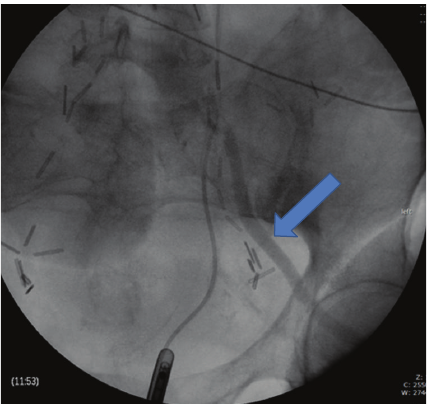
Figure 2: Attempted left internal iliac artery selective arteriogram with a 5 F SOS catheter shows the catheter tip in the left ureter and brisk flow of contrast into the left ureter (solid blue arrow) flowing caudad into the urinary bladder (solid red arrow). This confirms the presence of an internal iliac arterioureteral fistula.